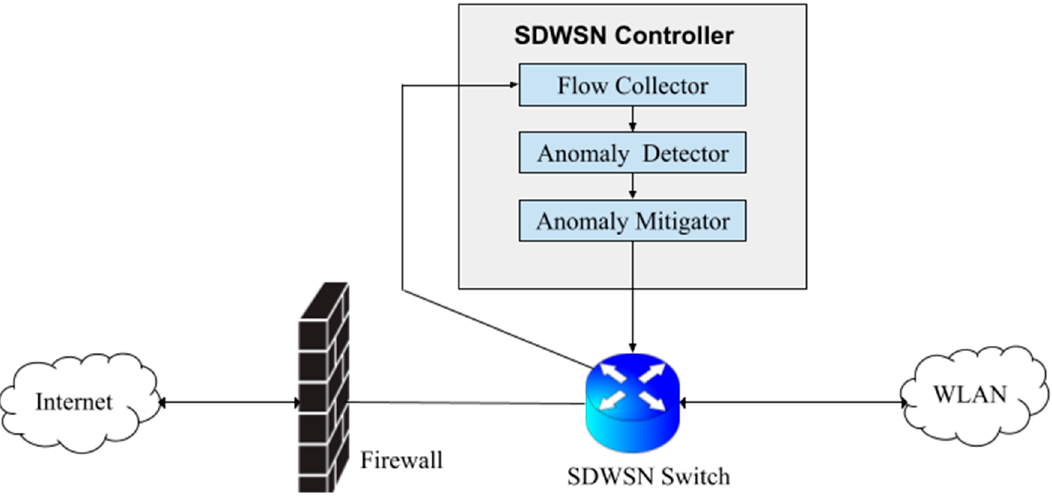
Figure 1. SDWSN-based IoTs IDS architecture (adapted from